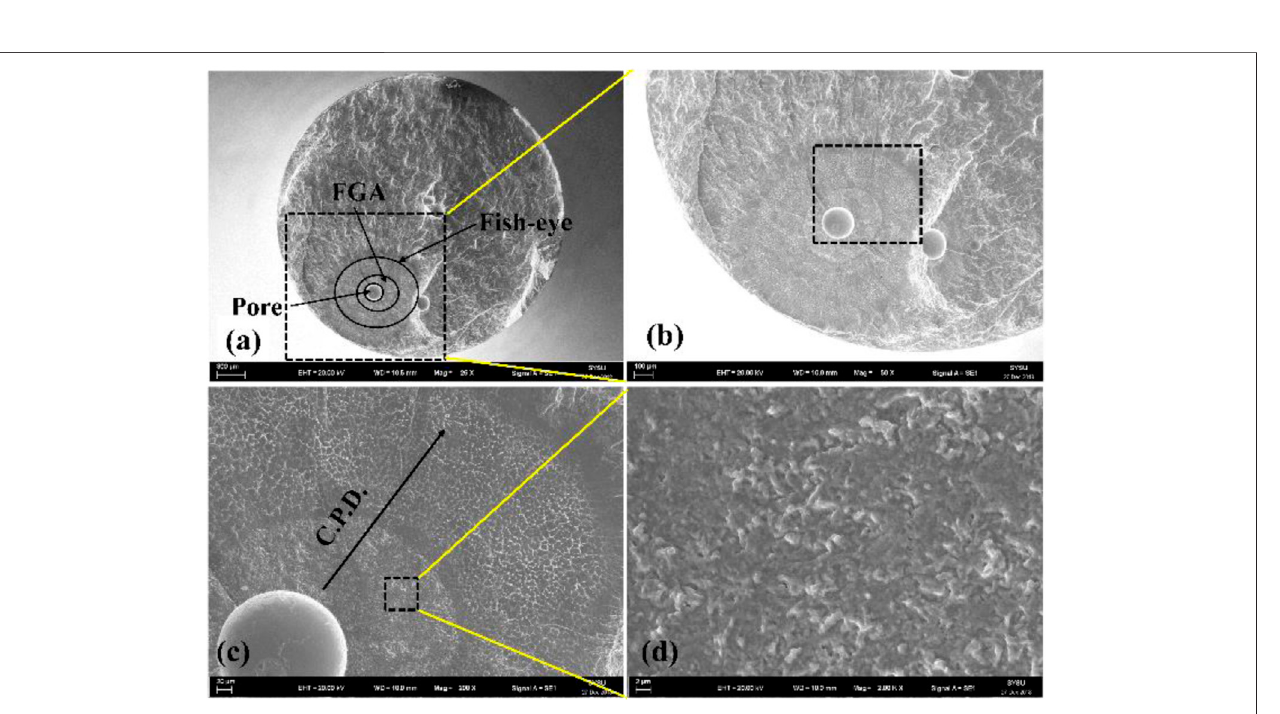
Frontiers in Energy Research |